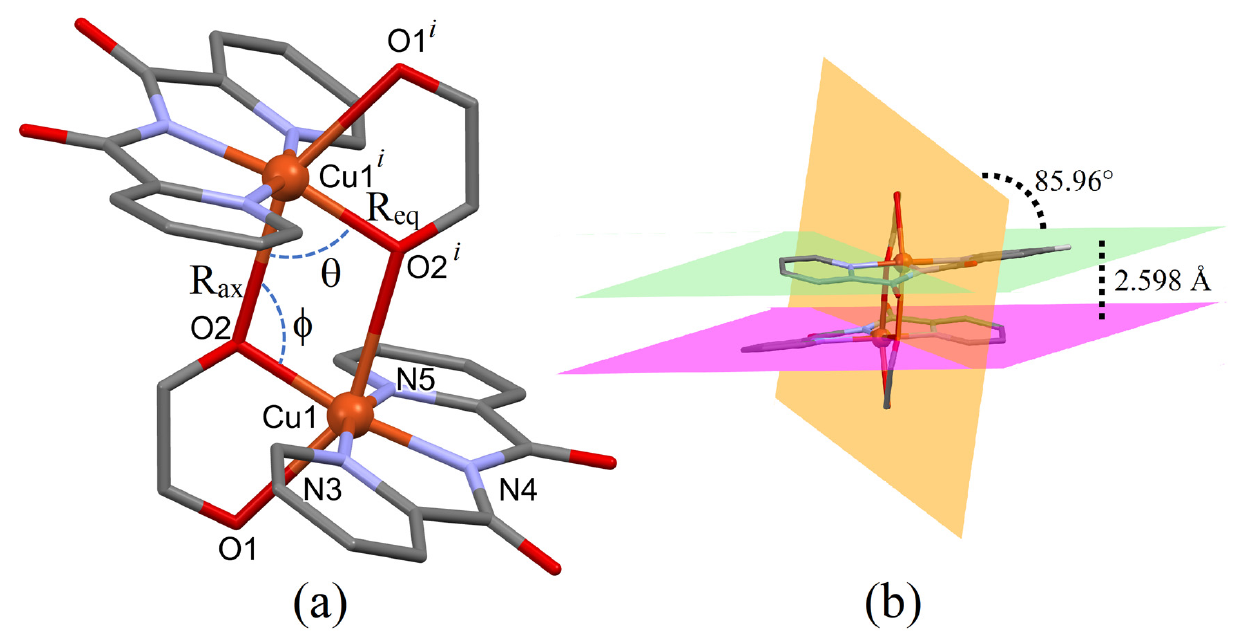
Figure 2. ( a ) Detail of the double oxo(carboxylate-oxamate)dicopper(II) entity in 1 depicting the equatorial Cu1–O2 [R eq = 1.969(1) Å] and axial Cu1–O2 ii [R ax = 2.629(2) Å] bond distances and the corresponding O2–Cu1–O2 ii [ θ = 74.37(7)°] and Cu1–O2–Cu1 ii [ φ = 105.63(8)°] bond angles within the Cu 2 O 2 core ( b ); a view of the mean metal equatorial planes thought the least-squares plane of the bridgehead carboxylate oxygens. Hydrogen atoms are hidden for the sake of clarity.